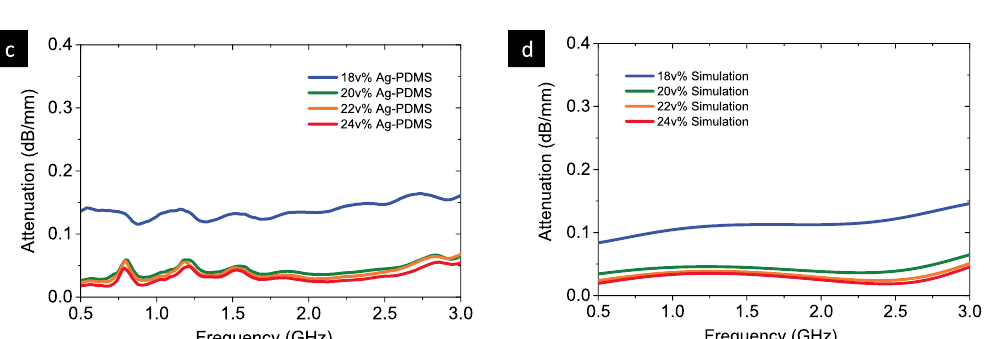
on-body scenario, the electromagnetic interaction with the human body becomes complex due to the biodiver- sity. The antenna matching, efficiency and radiation pattern sometimes will be quite different from the model and simulation result. In that case, experiments should be planned carefully to determine optimal design. The stretchable performance of the transmission line is verified with a maximum strain of 20%, as shown in Fig. 4. The change in attenuation of different Ag-PDMS transmission lines under quasi-static uniaxial strain was measured using a tailored polyethylene-only tensile test fixture. The stretching of the Ag-PDMS transmission line does not alter the attenuation much except for the 18 v% Ag-PDMS transmission line, where the average attenu- ation is above 0.05 dB/mm. As expected, the unstable conductive network in the 18 v% Ag-PDMS transmission line will be further degraded by the stretching, resulting in higher attenuation and conductivity loss. For wearable applications, the effective antenna radiation should be maintained to a certain level following the human body deformation. Wearable skin-like antenna is the new demand for wearable communication sys- tem. For the first time, the effective radiation of an Ag-PDMS enabled skin-like dipole antenna is experimentally demonstrated in the ultra-high frequency band, at frequencies with 800 MHz to 1000 MHz such as radio fre- quency identification (RFID), long-term evolution (LTE), global system for mobile communications (GSM) etc. The return losses of the dipole antenna under different stretching, twisting and bending cases were collected with a vector network analyzer, shown in Fig. 5. The antenna was placed on a polyethylene-only fixture for tensile or twist test, and placed on curved foam for the bending test. There is a clear minimum on the return loss around 920 MHz, as shown in Fig. 5b. Figure 5a shows the center frequency of the dipole antenna. To test the antenna tensile property, a tensile strain ranging from 0% to 15% was applied to the dipole antenna. Figure 5c shows the measured frequency response of the return loss and efficiency. It is found that the radiation efficiency around the initial resonance frequency degrades monotonically as the stretching percentage increases. With the increasing strain, the resonance frequency shifted to a lower frequency due to the increased effective electrical length. The Ag-PDMS conductor can be considered as hyperelastic material, therefore, when the antenna is elongated in the length direction, the width and height shrink proportionally to keep the total volume constant during deformation, resulting in poorer impedance match and a lower radiation efficiency. As shown in Fig. 5b, dielectrics in the close vicinity of the antenna have a large impact on the antenna per- formance. In both the stretching and twisting setups, a plastic fixture and white foams are used to support the antenna under test. Therefore, the difference between the 0% stretch case and the 0-deg twist case with respect to the antenna performance is insignificant. However, in the bending setup, without the plastic fixture, only white foams are used. As a result, the no-bend case behaves a bit different. Taking the return loss for instance, it provides a higher resonant frequency and a narrower impedance bandwidth. According to Fig. 5d, the radiation efficiency does not vary too much as the twisting angle increases. Moreover, the maximum variance is only about 5% between different twisting angles. This indicates that the radiation effi- ciency is not sensitive to the change of the twisting angle. Meanwhile, the return loss remains stable in most